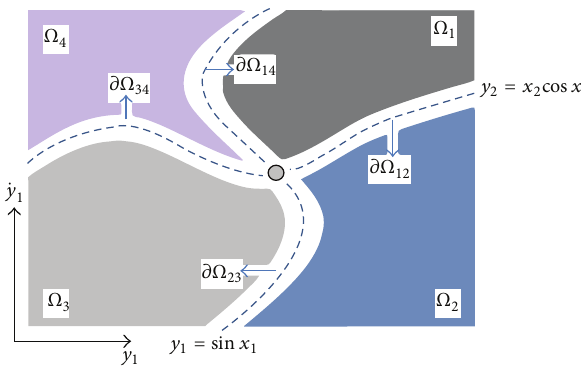
Figure 1: Subdomains and boundaries of controlled slave system in absolute coordinates.